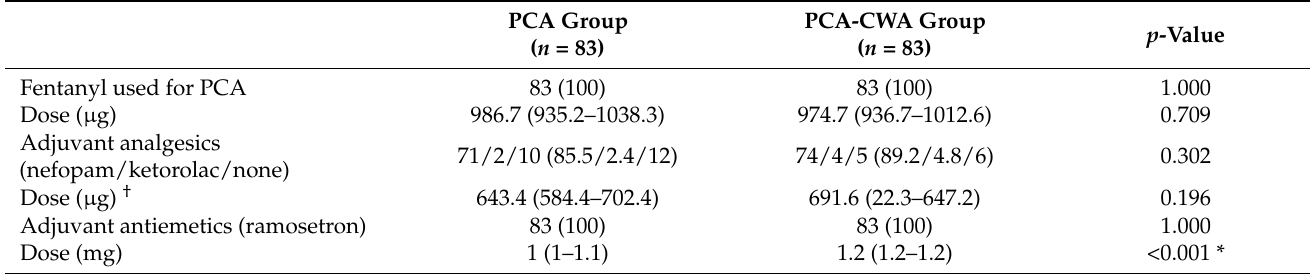
Table 4. Postoperative analgesia modalities after propensity score